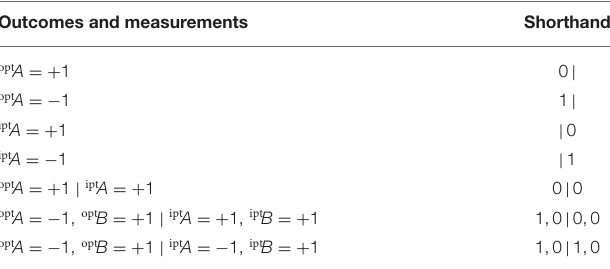
TABLE 2 | Conventional shorthands applied within the combinatorial approach of Acín et al. (2015). Outcomes and measurements Shorthand